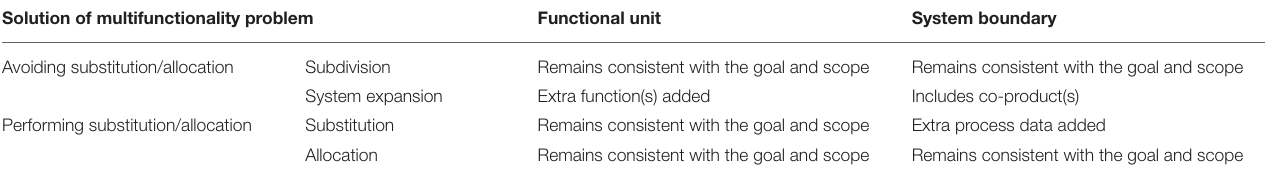
TABLE 1 | Overview of the main differences between the four proposed methods for dealing with multifunctional unit